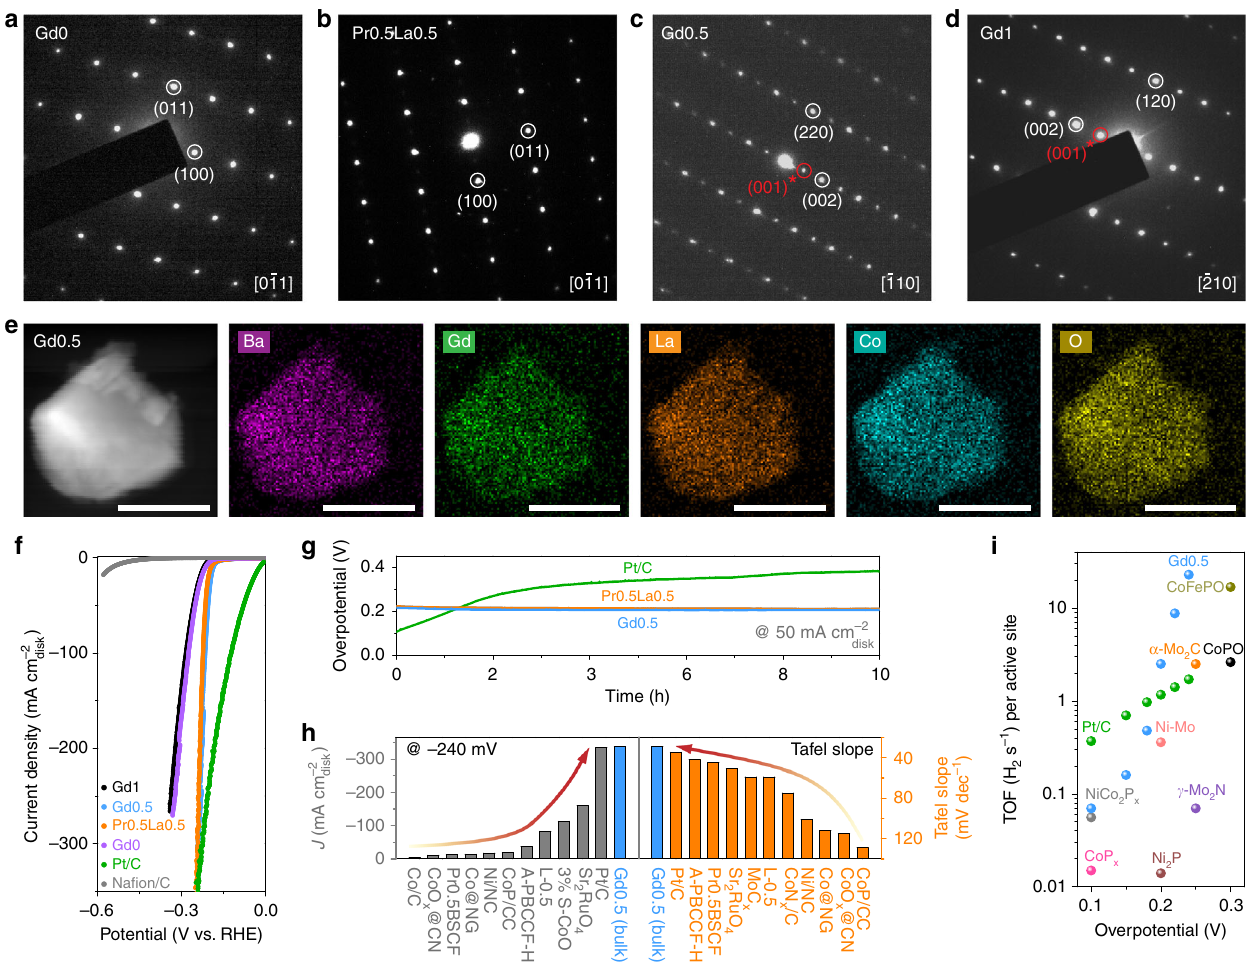
Fig. 3 Crystal structure and electrode HER activity. SAED patterns of a Gd0, b Pr0.5La0.5, c Gd0.5, and d Gd1 perovskites. e HAADF-STEM image and elemental mapping of Gd0.5 sample. Scale bar is 100 nm. f Electrode HER polarization curves of Gd1, Gd0.5, Pr0.5La0.5, Gd0, Pt/C, and Na fi on/C catalysts. g Chronopotentiometric curves of Gd0.5, Pr0.5La0.5, and Pt/C materials at 50 mA cm − 2 disk . h HER activity comparisons of disk current density at − 240 mV and Tafel slope between Gd0.5 perovskite and recently reported state-of-the-art electrocatalysts. i Comparisons of TOF values obtained on Gd0.5 material at different overpotentials with those of other well-known HER